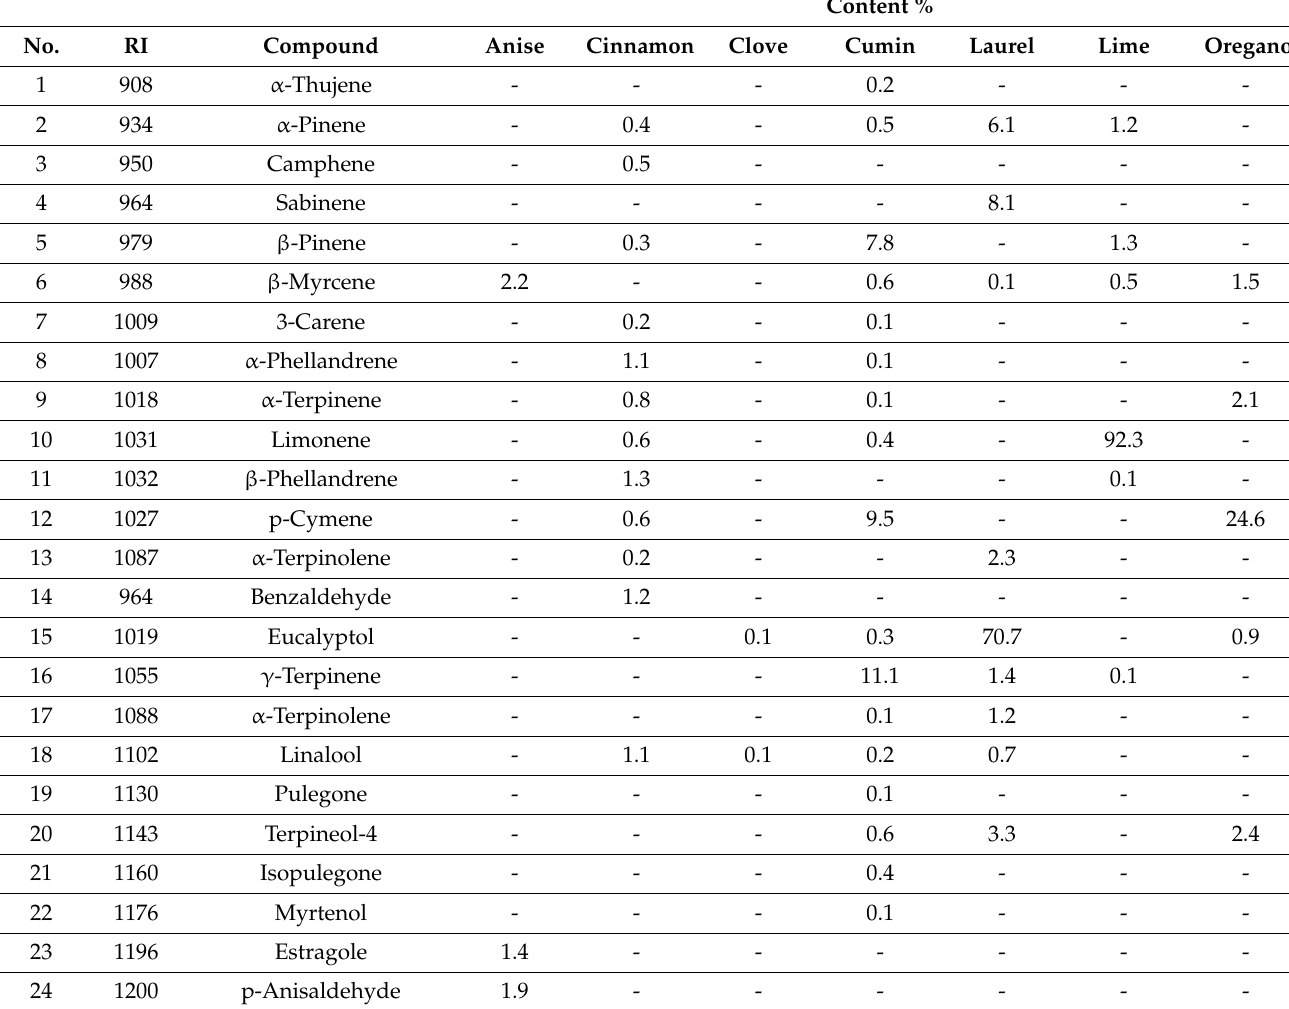
Table 1. Chemical composition of the essential